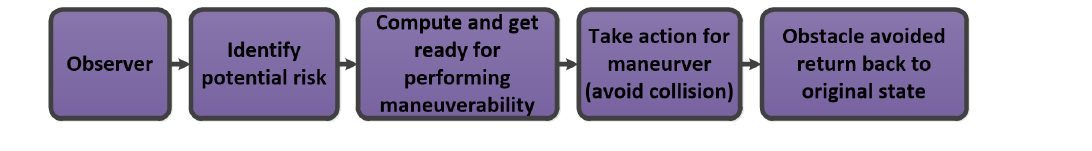
Figure 2. Steps involve in